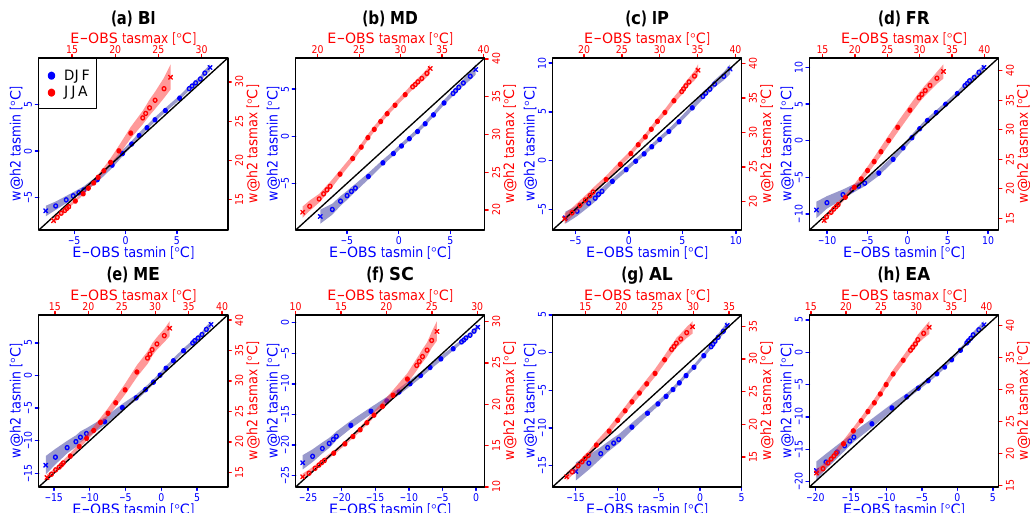
Figure 11. Quantile–quantile plots of the distribution of (red) JJA daily maximum temperature (tasmax) and (blue) DJF daily minimum temperature (tasmin) for the eight regions, comparing w@h2 to E-OBS over years 1950–2006. Blue axes (bottom, left) are for DJF tasmin, red axes (top, right) are for JJA tasmax. Dots show the quantile values for the entire ensemble (filled dots: deciles; empty dots: 1st to 5th and 95th to 99th percentiles; cross symbols: 0.5th and 99.5th percentiles). The coloured envelopes show the 95% confidence interval of w@h2 quantile values from 1000 bootstrap samples with one ensemble member per year (see text).